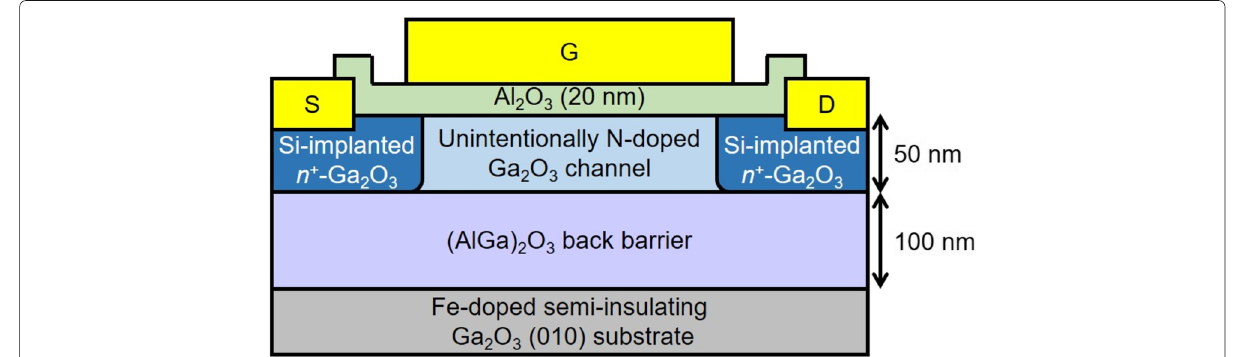
Fig. 12 Schematic cross section of Ga 2 O 3 MOSFET with unintentionally N-doped channel. Adapted with permission [93]. Copyright 2019, IEEE